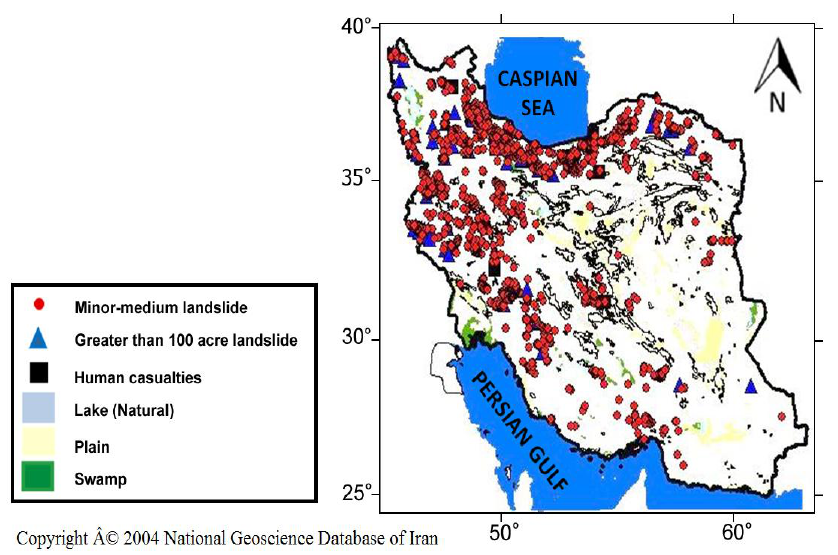
Figure 1. Landslide distribution map of Iran